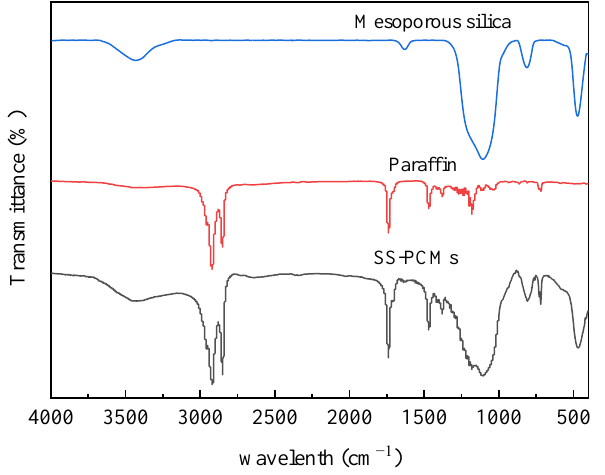
Figure 3. FT-IR spectra of paraffin, MS and paraffin/MS SS-PCMs.